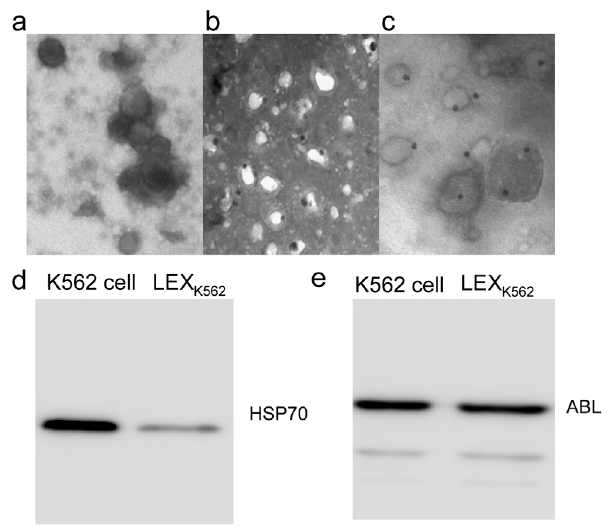
Figure 1. Morophology and expression of heat shock protein 70 and ABL in LEX K562 . (a) Transmission electron micrograph of K562 cell-secreted exosomes ( 6 100K). (b and c) Electron micrograph of heat shock protein 70 (HSP70)- and ABL-labeled exosomes. (d) Western blot analysis demonstrating the presence of HSP70 and ABL molecules in K562 cells and K562-derived exosomes (LEX K562 ).